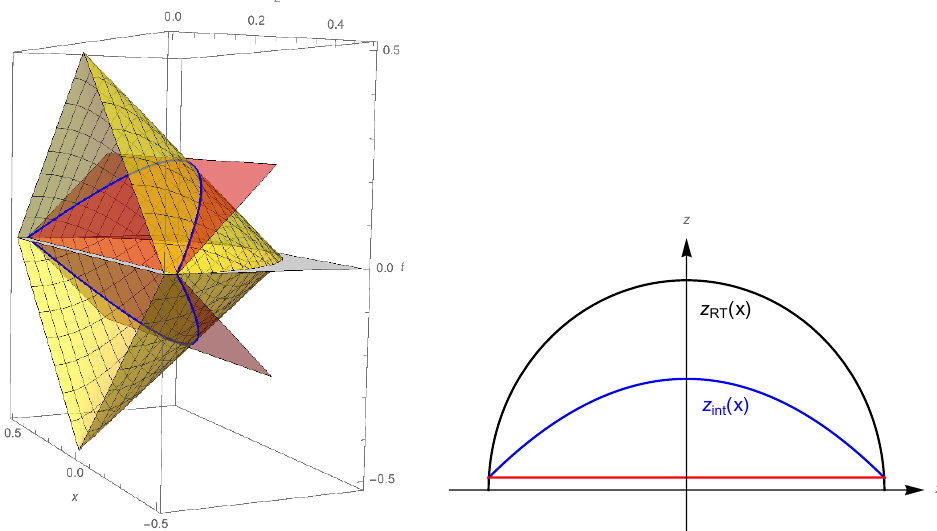
Figure 2 . Left: intersection of WDW patch with entanglement wedge in the ( x; z; t ) space. The boundary of the entanglement wedge is in yellow, while the boundary of the WDW patch is in red. Right: intersections in the ( x; z ) plane, with z RT in black, z int in blue and the cuto(cid:11) z = " in